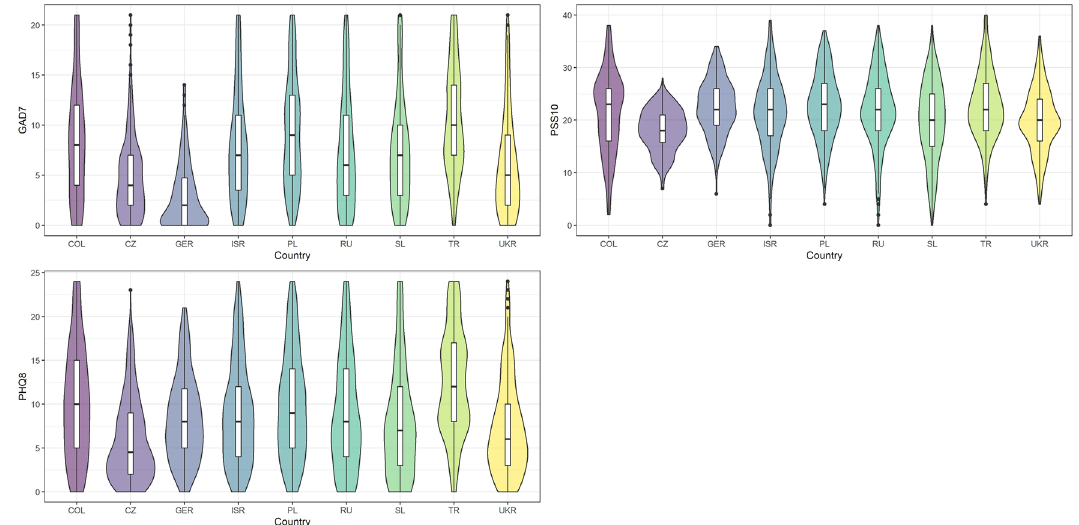
Figure 2. Distribution of anxiety (GAD-7), perceived stress (PSS-10), and depression (PHQ-8) parameters within each surveyed country presented by violin and box plots. COL = Colombia, CZ = Czechia, GER = Germany, ISR = Israel, PL = Poland, RU = Russia, SL = Slovenia, TR = Turkey, UKR =